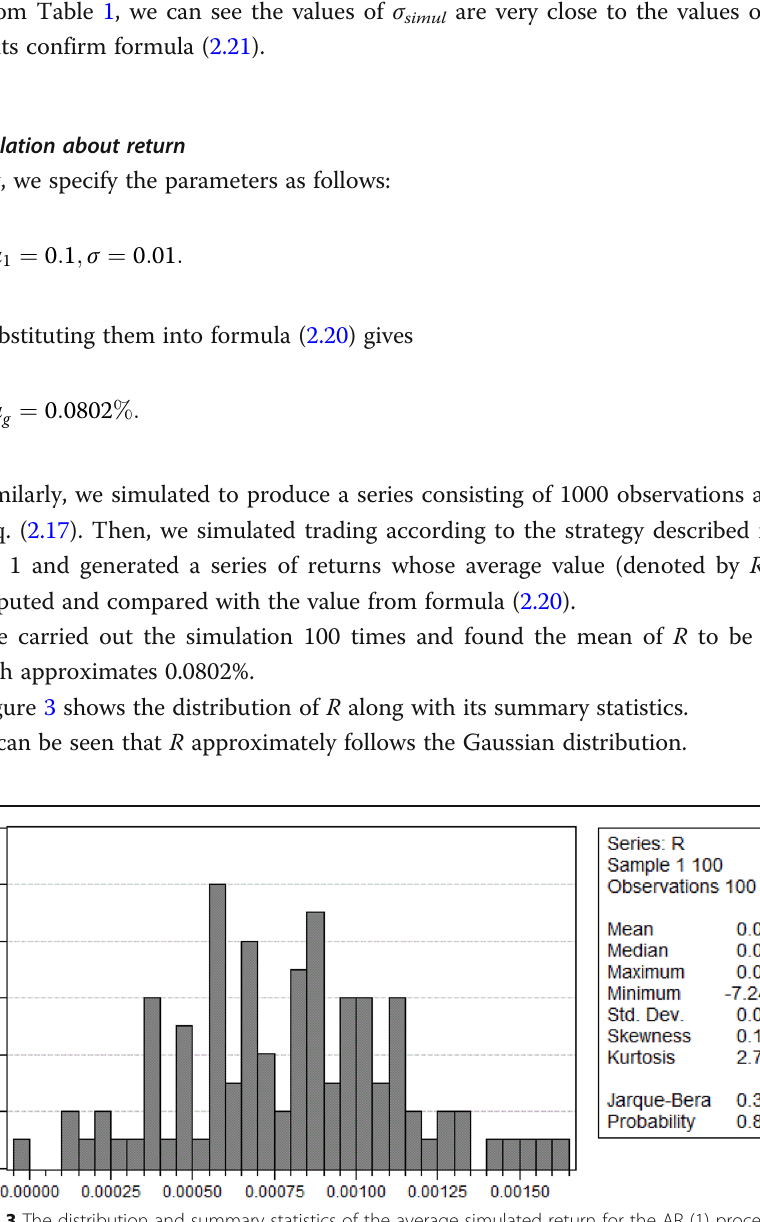
Fig. 3 The distribution and summary statistics of the average simulated return for the AR (1) process. We use R to denote the average value of the simulated returns. The distribution of R is shown in the left, and the summary statistics are listed in the